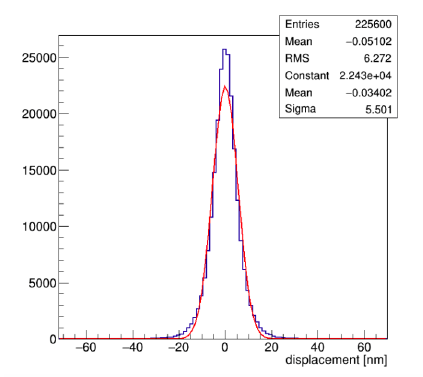
Figure 1. Achieved position accuracy better than 10 nm.